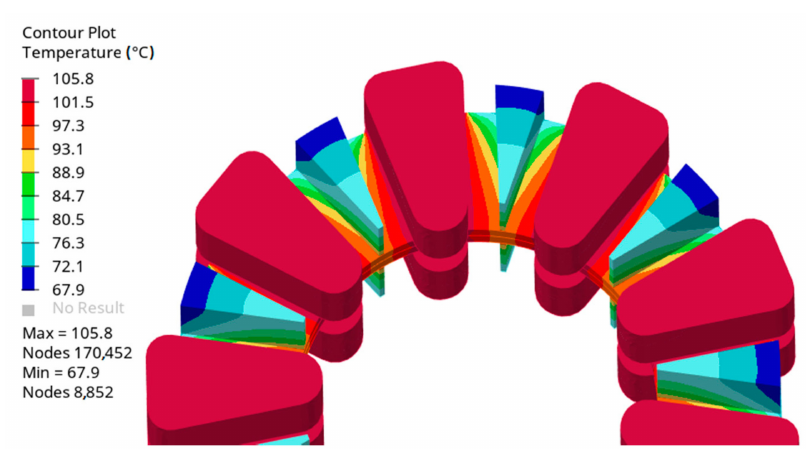
Figure 23. An enlargement of the temperature distribution in the stator